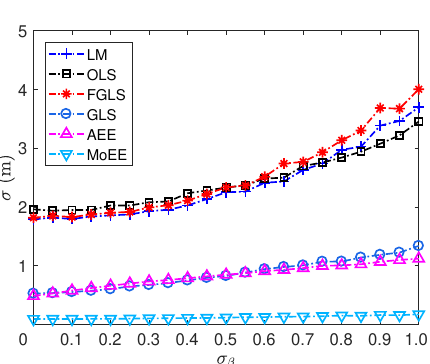
Fig. 5 Effects of error with estimated ˛˛˛ .